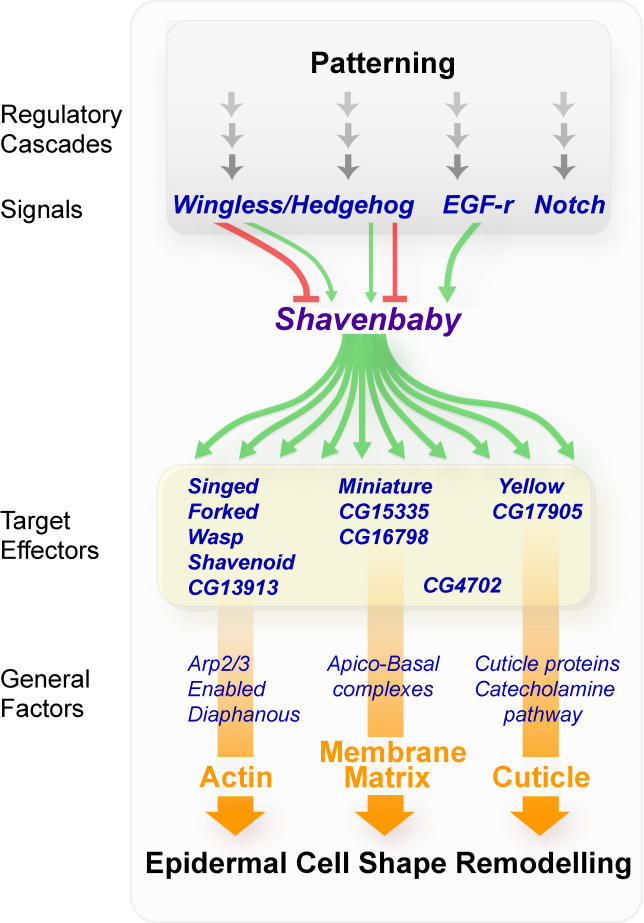
Model of svb Regulation and Activity during Denticle FormationDuring epidermal differentiation, regulatory regions governing svb transcription integrate outputs from many signaling pathways (Wg, Hh, and DER) and positional cues to define the precise subset of epidermal cells that express svb. The Shavenbaby transcription factor triggers in turn the expression of different classes of genes encoding cellular effectors. They are directly involved in distinct aspects of trichome formation, including the reorganization of actin (singed, forked, wasp, and shavenoid), extracellular matrix (m) and cuticle (y), likely through modifying the activity of ubiquitous cellular machineries. Additional cytoskeletal factors or regulators (independent of svb) might be required for the fine sculpturing of each kind of trichome, characteristic of a given body region. Modifications of svb cis-regulatory regions thus provide a rich source of plasticity to evolve the trichome pattern and generate morphological diversification throughout species.